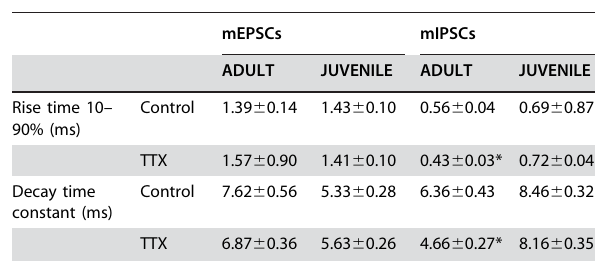
Table 1. Kinetics of mEPSCs and mIPSCs recorded from adult and juvenile CA1 pyramidal cells 48 hours after implantation with control Elvax or TTX Elvax (asterisks indicate significant difference (p # 0.05)). .. ... .... ... ... .... ... ... .... ... ... .... ... ... .... ... ... .... ... ... .... .